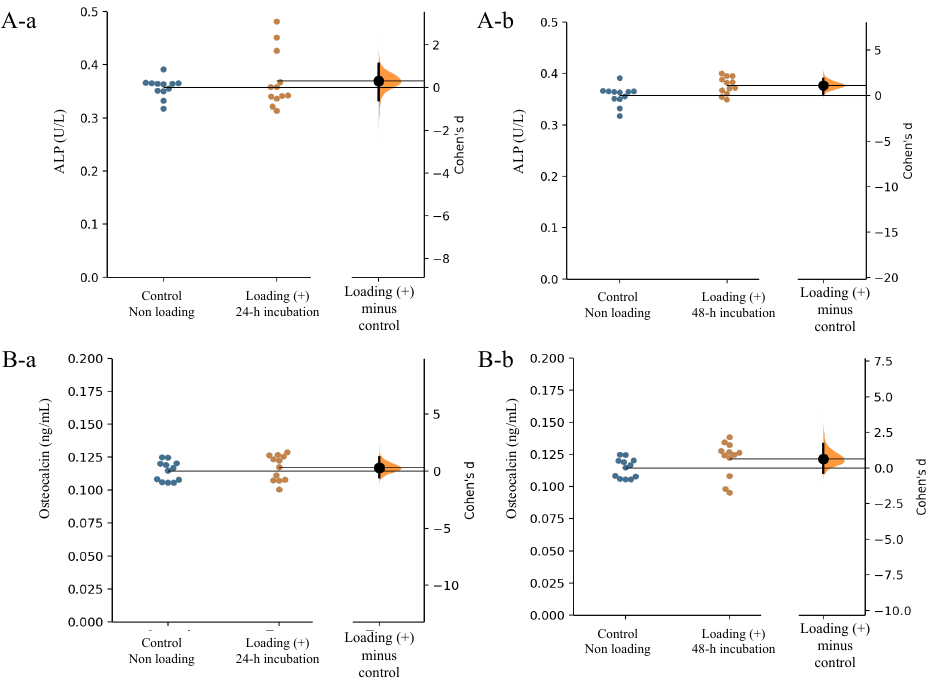
Figure 3. Effects of mechanical loading on osteoblast activity. Cohen’s d between the control and the mechanical loading group is shown in the above Gardner–Altman estimation plot. Both groups are plotted on the left axes; the mean difference is plotted on a floating axes on the right as a bootstrap sampling distribution. The mean difference is depicted as a dot; the 95% confidence interval is indicated by the ends of the vertical error bar. The effect sizes and CIs are reported above as effect size (CI width lower bound; upper bound). ( A ) ALP: ( a ) control group versus mechanical loading (+)-24 h incubation group, ( b ) control group versus mechanical loading (+)-48 h incubation group. ( B ) Osteocalcin: ( a ) control group versus mechanical loading (+)-24 h incubation group, ( b ) control group versus mechanical loading (+)-48 h incubation